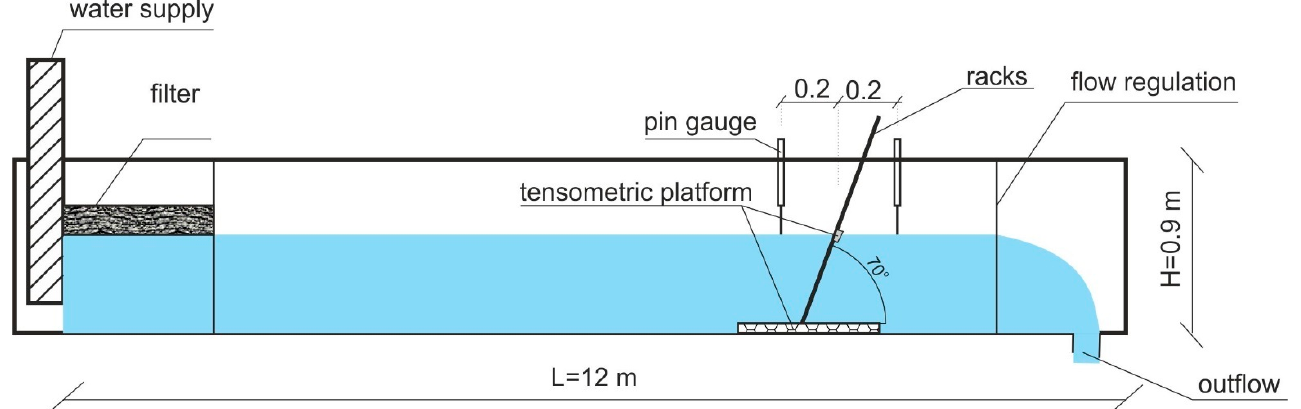
Figure 1. Scheme of laboratory test.